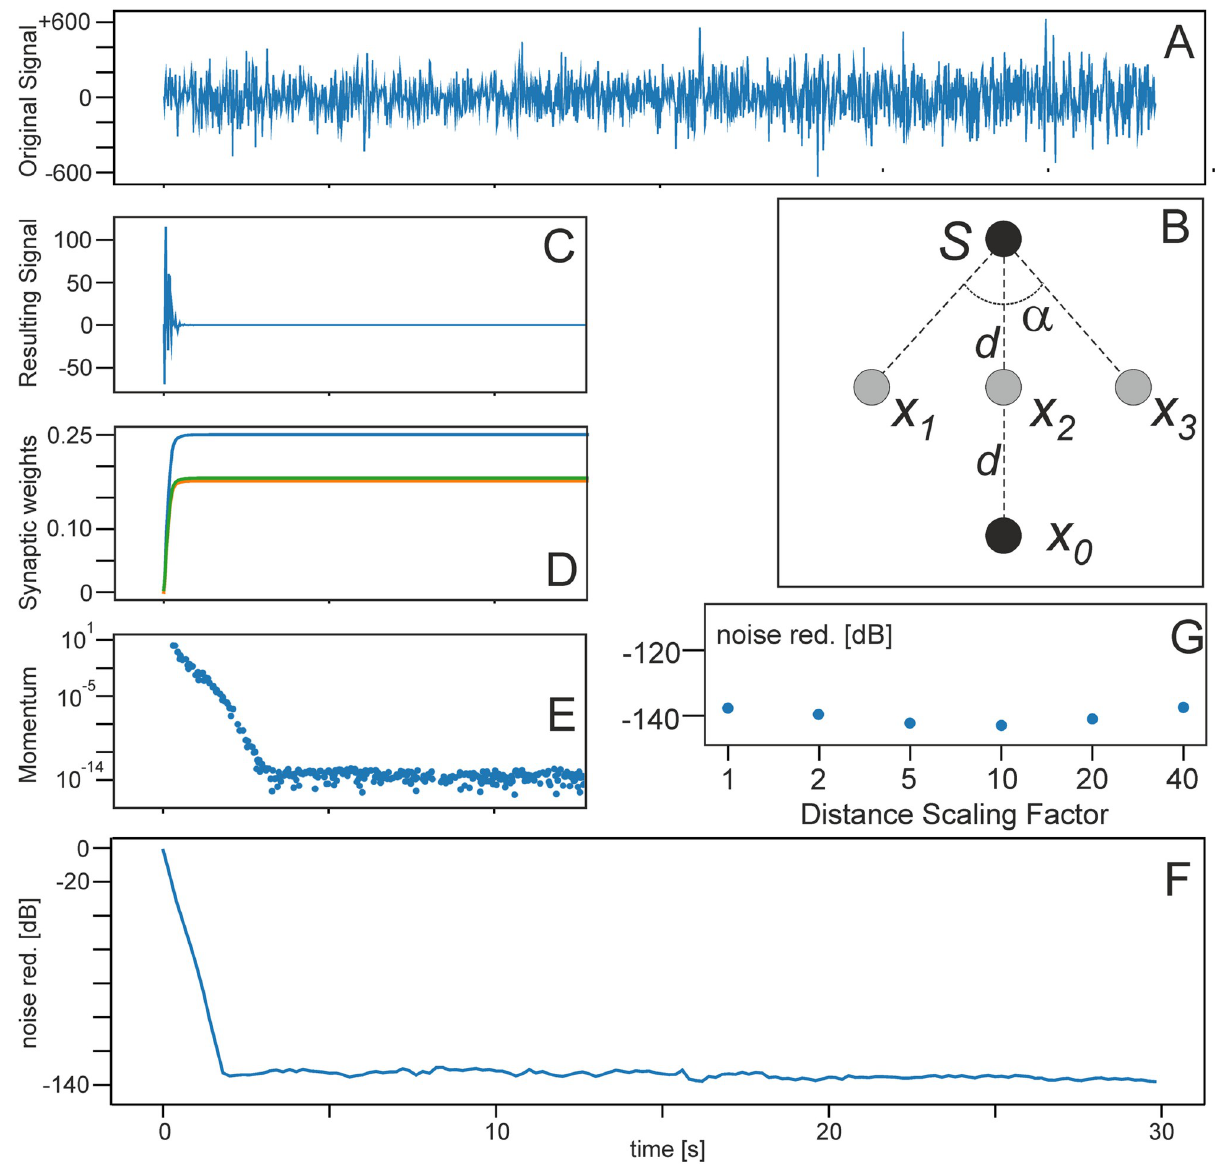
Fig 3. Results for a linear microphone setup. A Original mixed noise signal. B Microphone and noise-source geometry, α = 90˚, d = 1.25 m . (C-E in arbitrary units and truncated after 12 s as there are no more changes visible afterwards). Learning rate: μ = 1.0 × 10 − 7 . C effective noise at the reference site, D weight dynamics, green and orange curves are identical due to the symmetry of the microphone configuration and are here shifted a bit to make both visible, E development of the momentum, and F achieved noise reduction. G Noise reduction when scaling d in the configuration with different